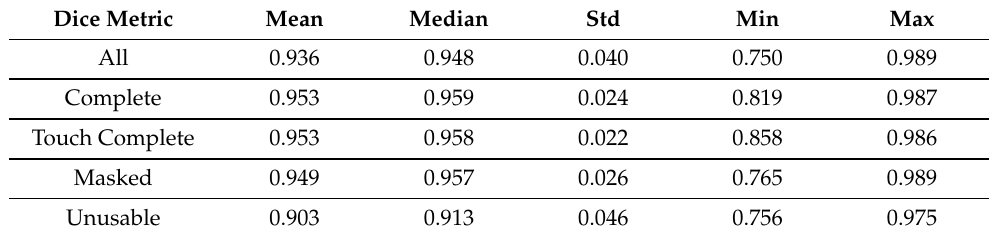
Table 4. Sørensen–Dice coefficient statistics over detected